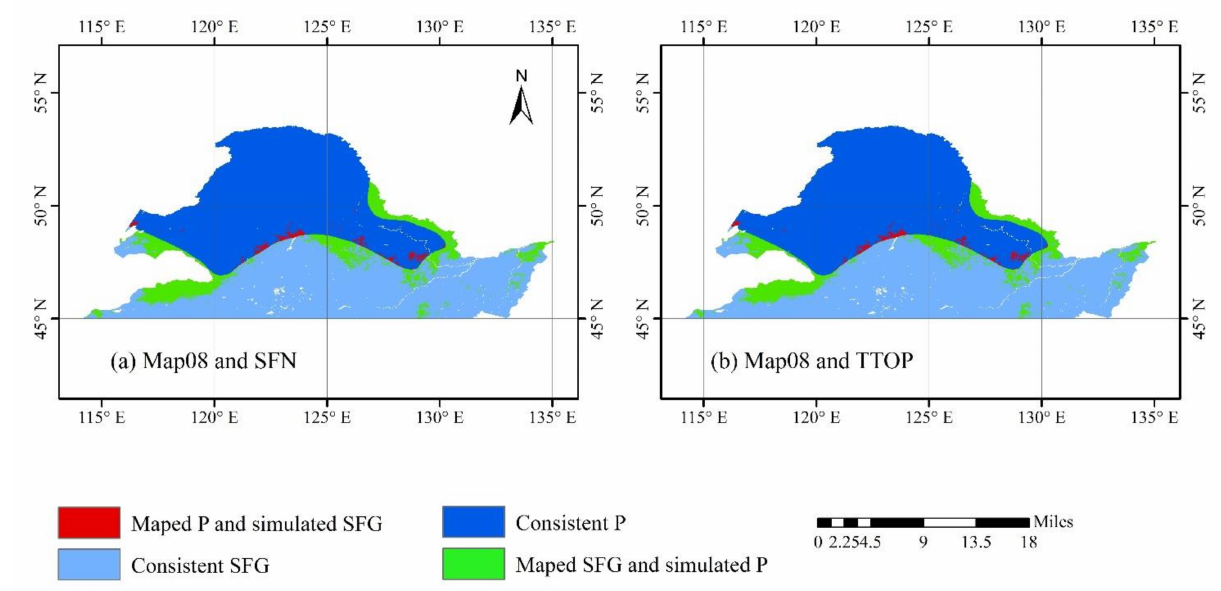
Figure 6. Spatial differences in permafrost distribution between ( a ) Map08 and SFN model, ( b ) Map08 and TTOP model, (P: permafrost, SFG: seasonally frozen